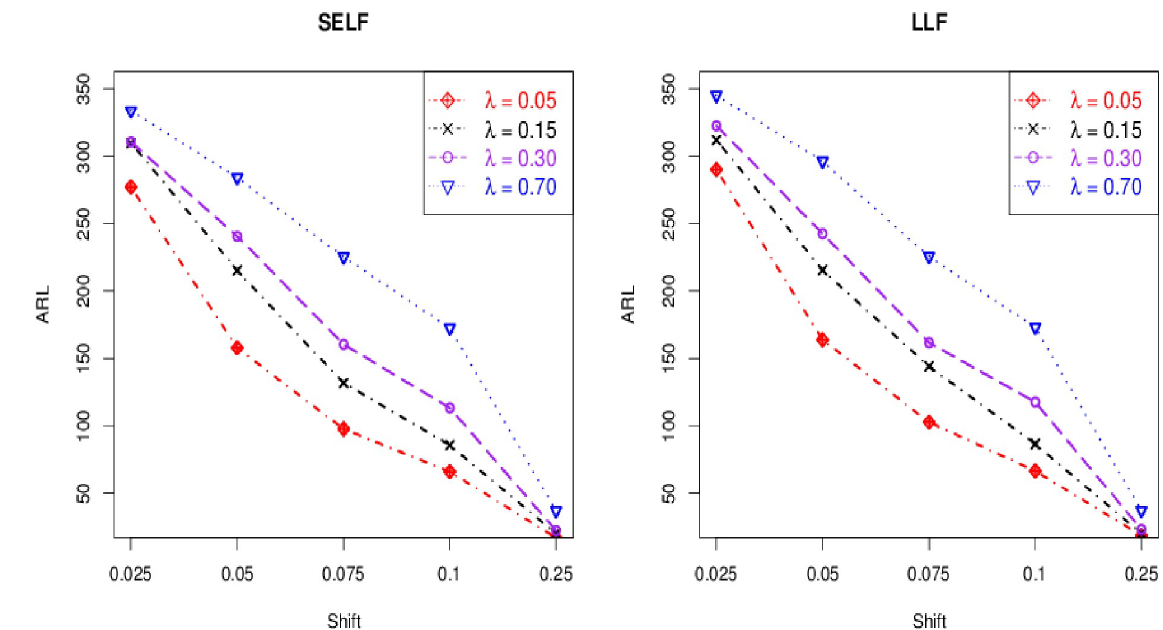
Fig 1. ARL curves for n = 5 and ARL 0 = 370 under different values of smoothing constant λ .